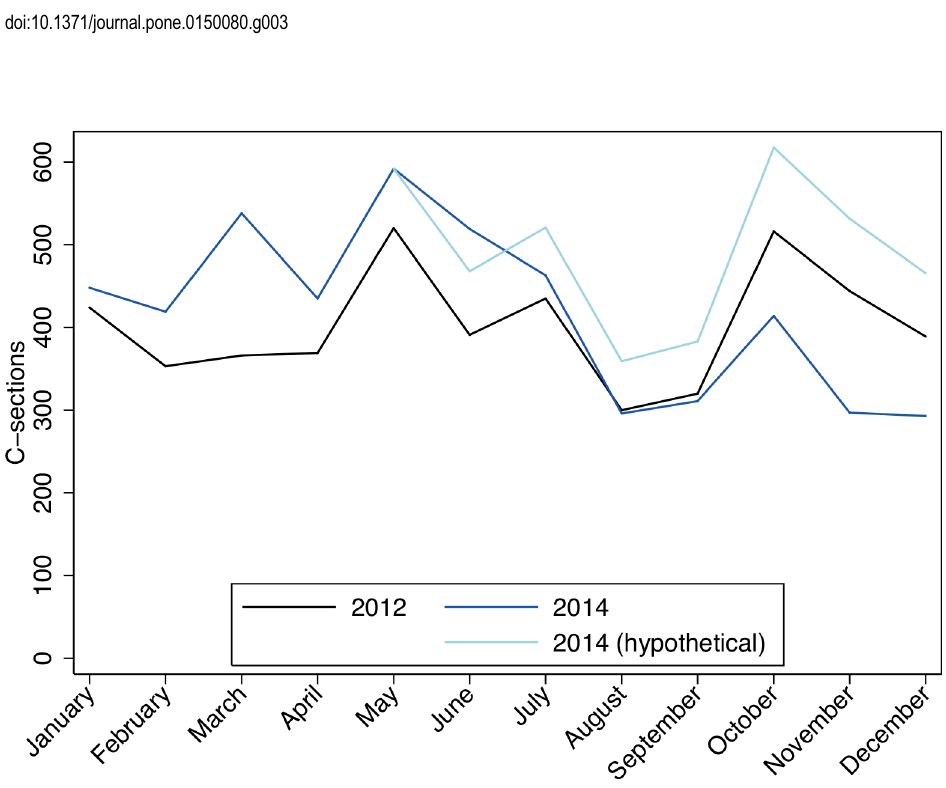
Fig 4. Seasonal variations of number of C-sections in 2012 (black), 2014 (dark blue) and hypothetical numbers (light blue).